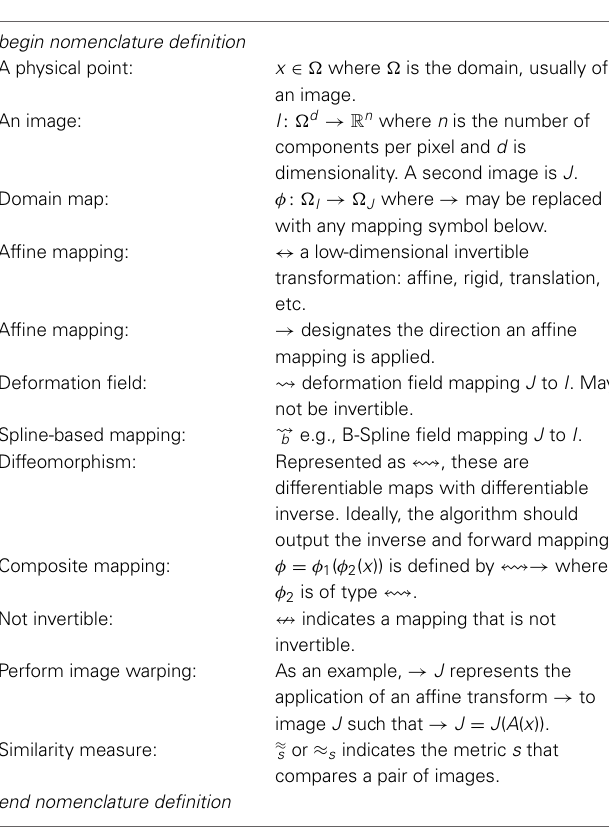
Second, we remove the shape (diffeomorphic) differences (D) . Consequently, we have a composite mapping, computed via the mutual information similarity metric, that identifies I ( x ) ≈ mi J ( A ( φ ( x ))) = J Affine ( y ) = J ( z ). The image J Affine ( y ) represents J after application of the affine transformation A i.e., J ( A ( x )). Code and data for this example are